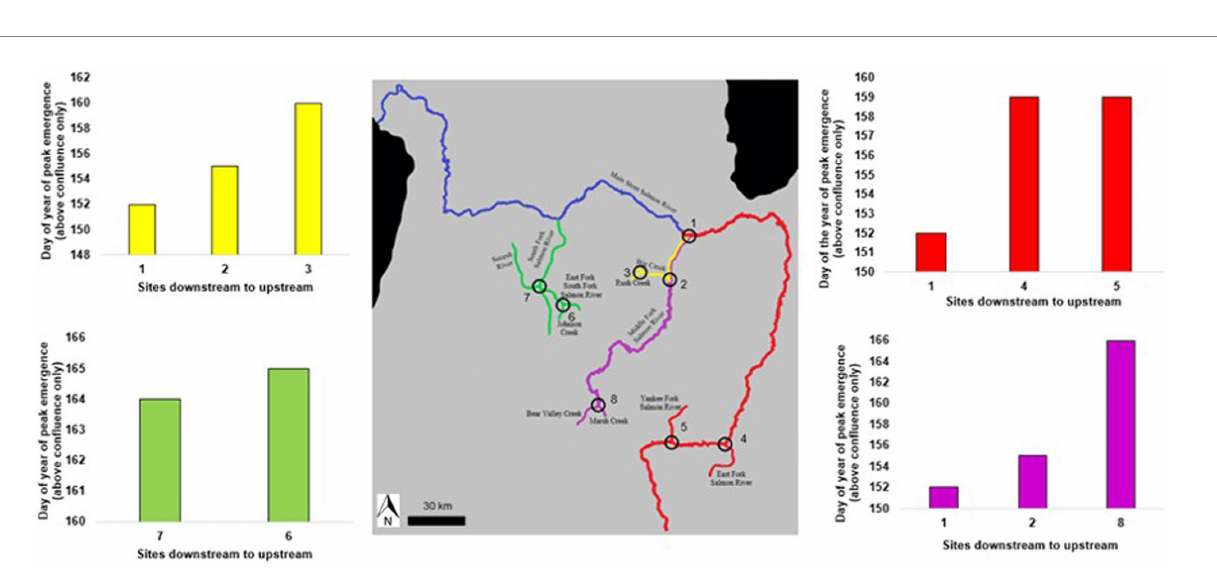
FIGURE 4 Timing of salmonfly emergence in the Salmon River sub-drainages, Idaho, United States in June 2018, following longitudinal pathways. At this sub- drainage scale, we started the downstream end of each pathway above respective confluences, which reveals how the pattern of emergence consistently appears to proceed from down to upstream when such confluence effects are excluded (as compared to what occurs at the scale of such confluences, see Figure 6). Numbers indicate confluences as labeled in Figure 2. Different colors indicate river sub-drainages.